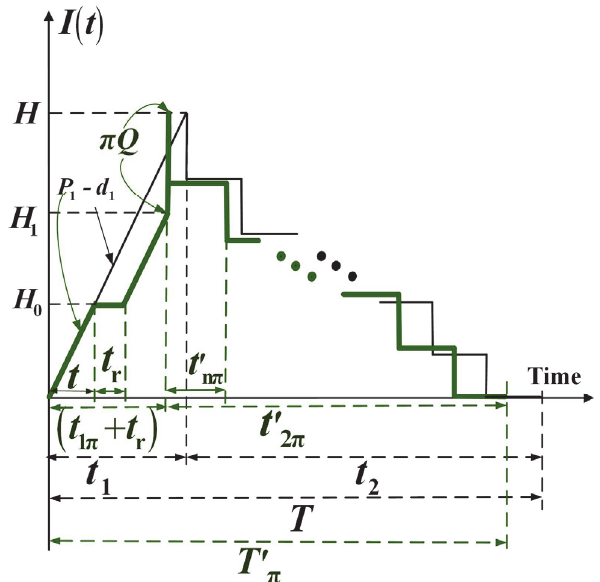
Fig. 1. The finished stock level in the proposed system considering random scrap, outsourcing, stochastic breakdown, and multi-shipment distribution plan (in green) as compared to that of a batch system with scrap and multi-shipment plan (in black)